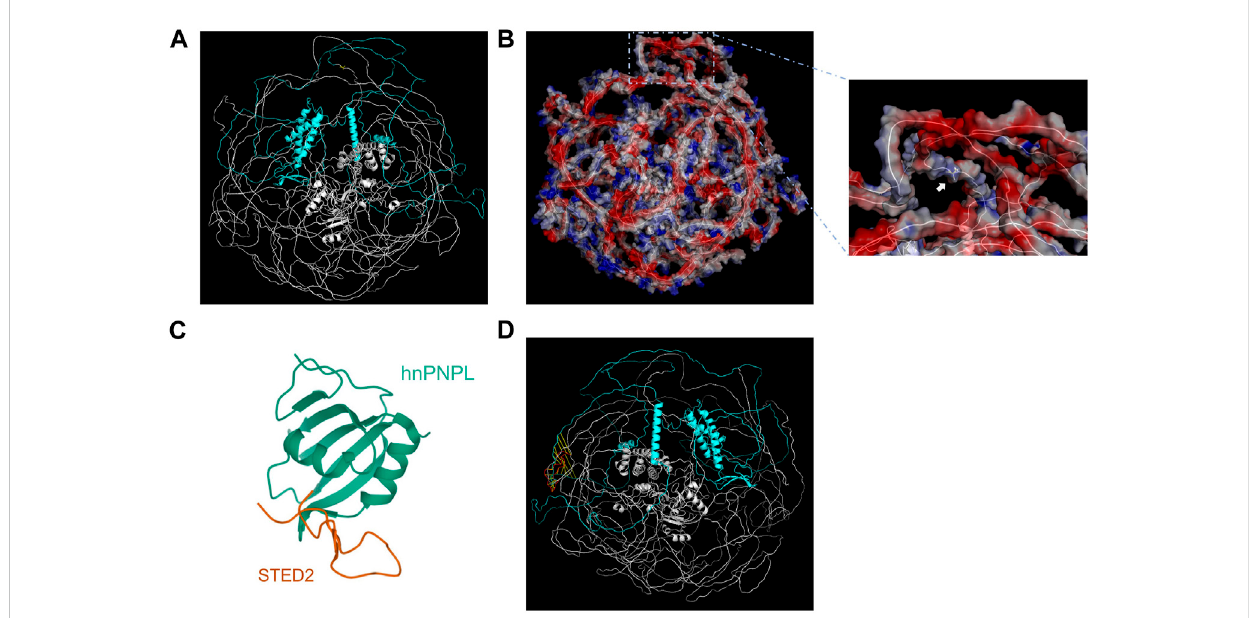
FIGURE 1 Genetic analysis of SETD2 gene. (A) Pedigree diagram and Sanger sequencing result of the family. (B) Evolutionary conservative analysis of SETD2. 2,475 – 2,504 stands for the amino acid residues from the 2475th site to 2504th site located in the SRI domain of SETD2 protein. (C) and (D) . The effect of p. A1946Rfs*2 variant on the structure of SETD2 protein and overview of reported SETD2